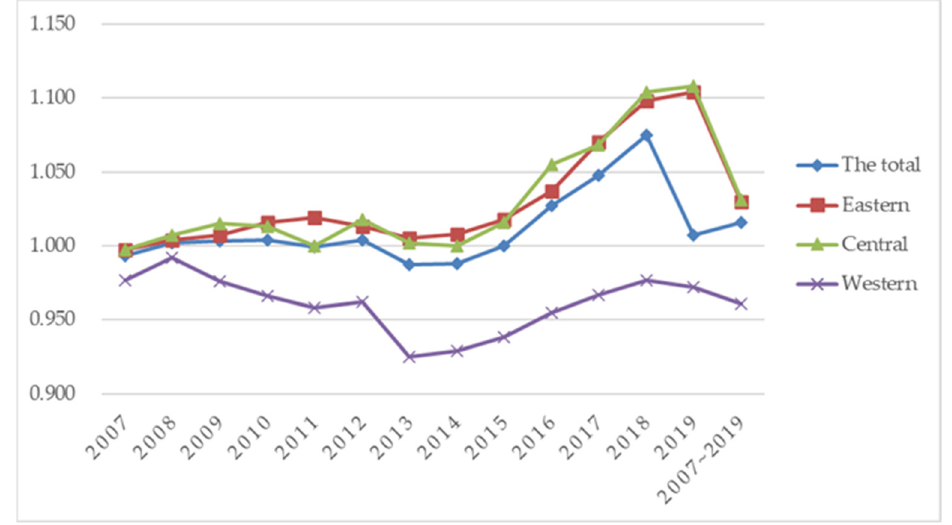
Figure 2. Green total-factor productivity (GTFP) in different regions of China.